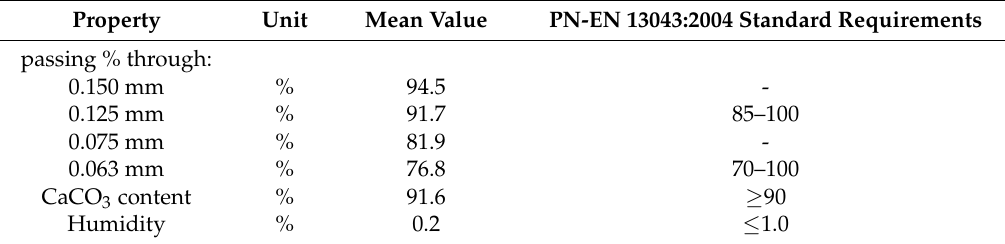
Table 3. Parameters of limestone dust.